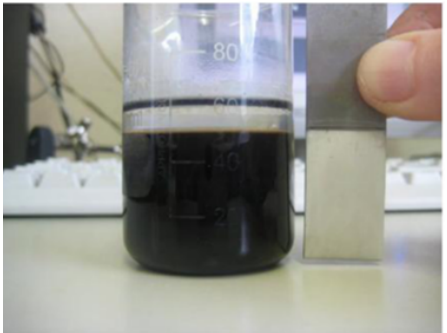
Figure 4. Aluminum deposited over a steel strip by the use of ionic liquid solution organic electroly- sis, data from